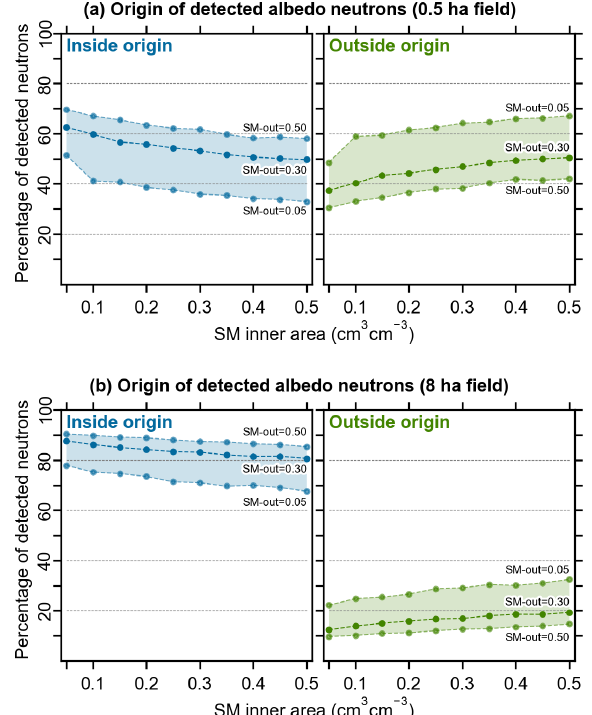
Figure 5. Percentages of detected neutrons that originate in the in- ner and outer area for (a) the 0.5ha scenario and (b) the 8ha sce- nario. These results are shown for a detector with a 25mm HDPE moderator with gadolinium